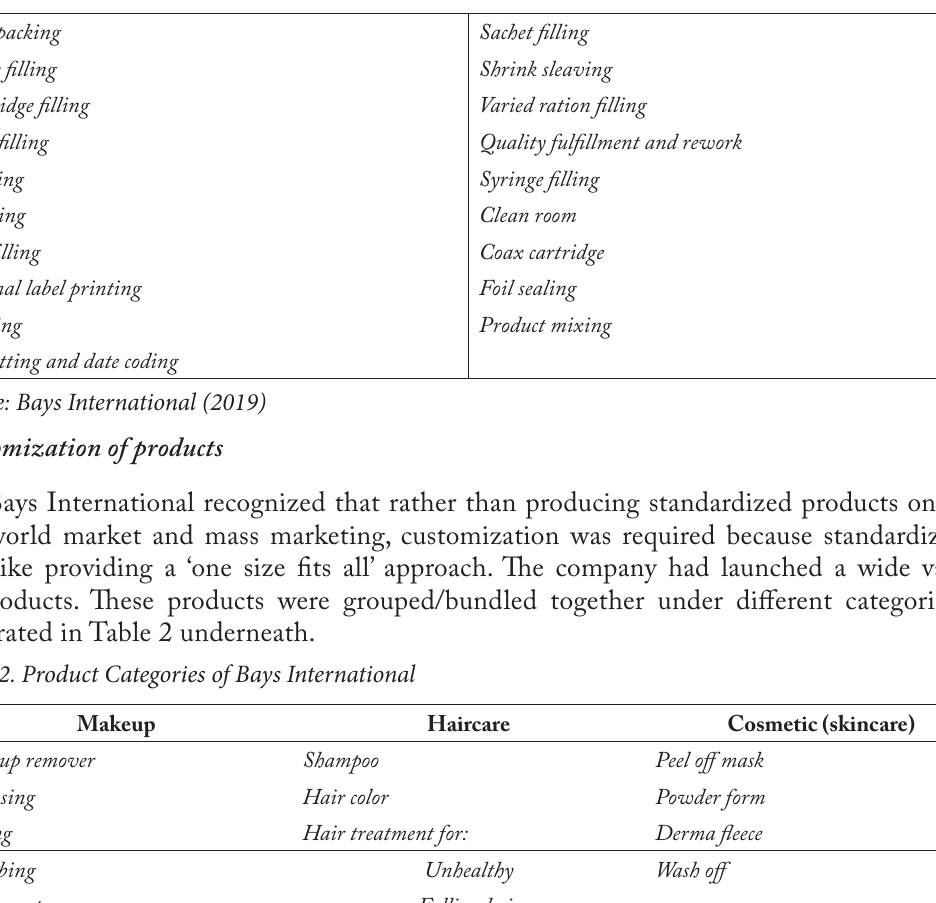
Table 1. Services of the Packaging Department